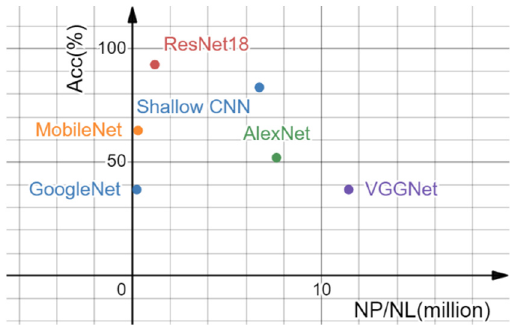
Figure 12. Relationship between NP/NL and accuracy of the network.